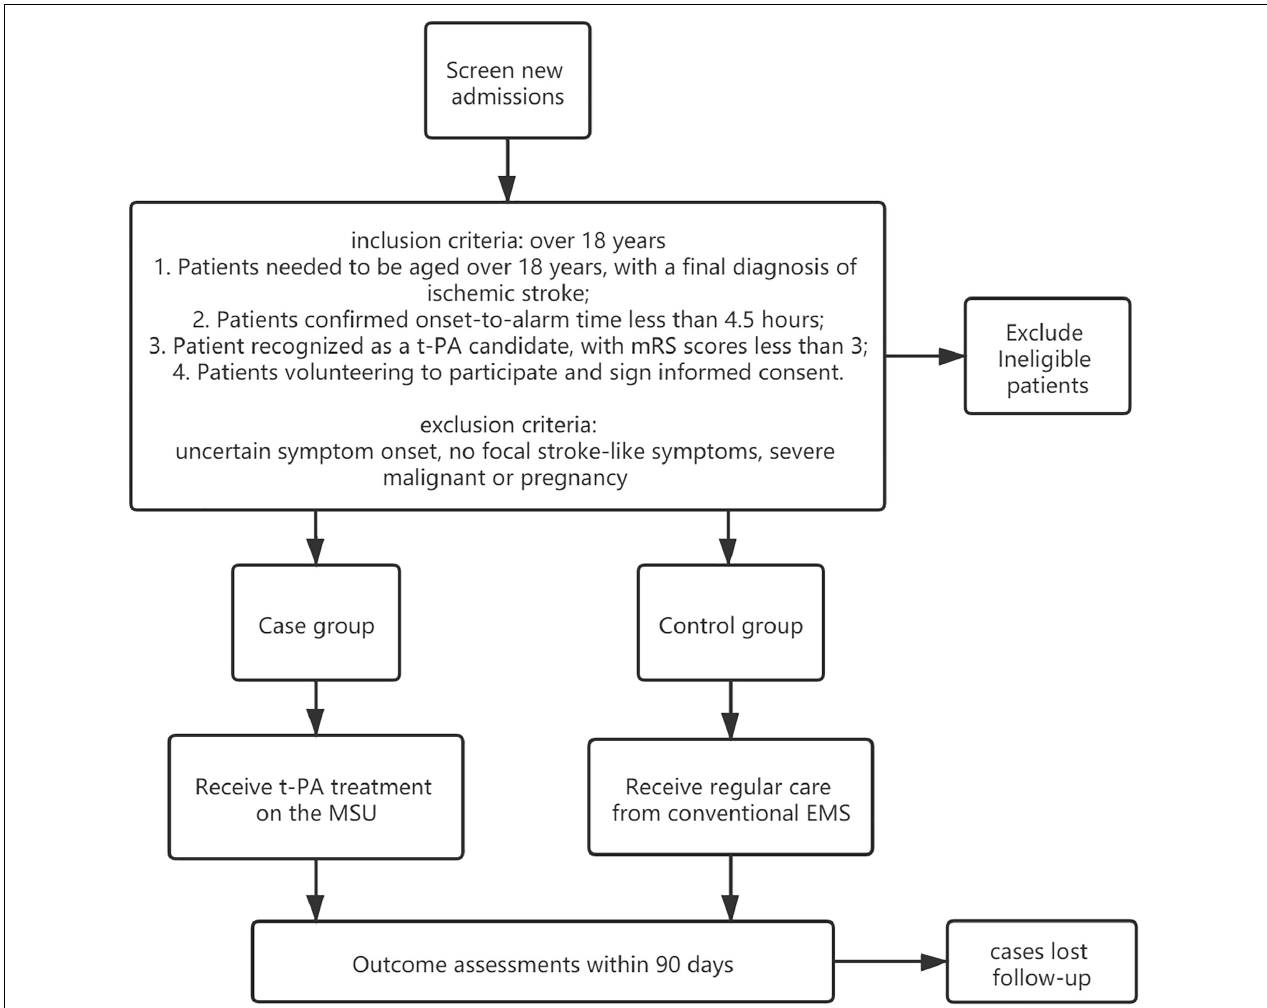
FIGURE 2 | Regular care life chain versus 5G-based SSES life